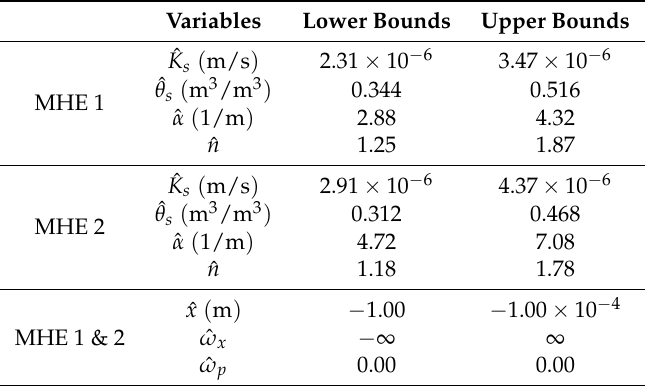
Table 5. Lower and upper bounds used in DeMHE.